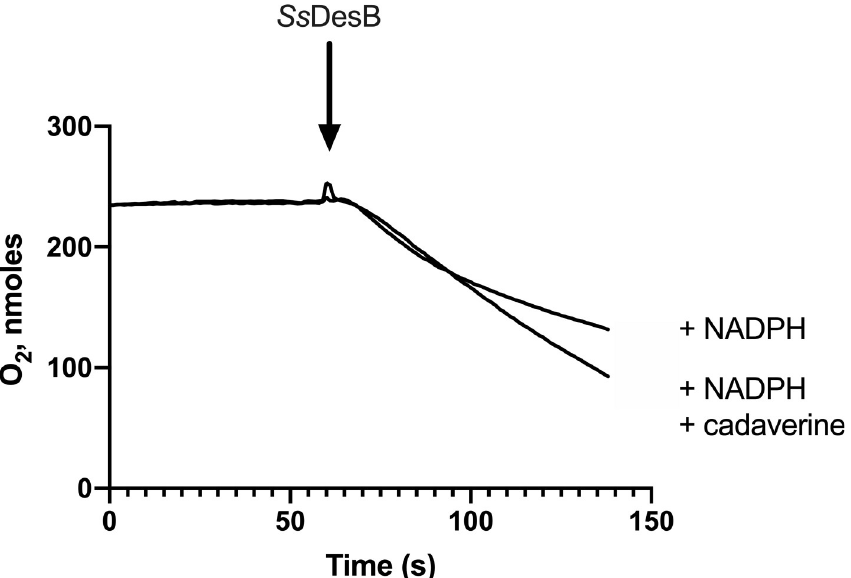
Fig 2. Oxygen consumption assays. Oxygraph traces demonstrate high oxidase activity in the absence of substrate. Assays contained 100 mM sodium phosphate buffer, pH 8 with 0.7 mM NADPH and 0.05 mM FAD in the absence or presence of 10 mM cadaverine.